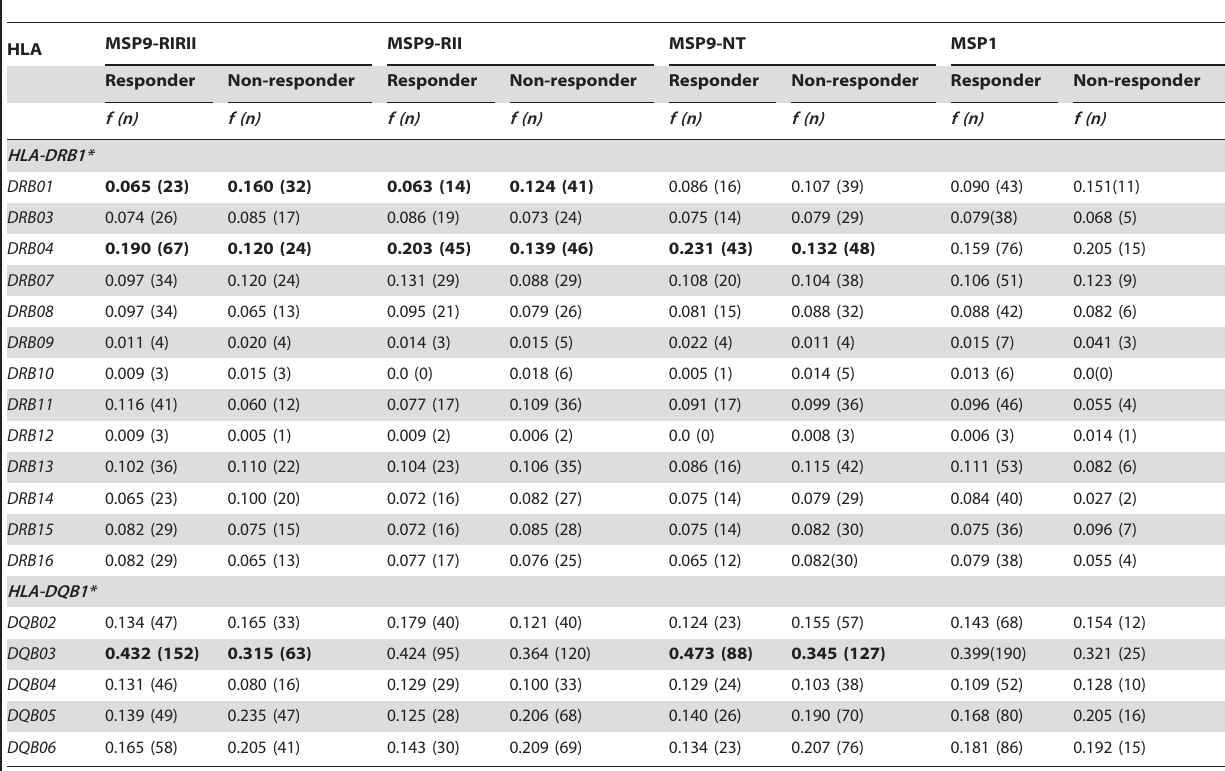
Table 3. Frequency (F) and number (n) of IgG responders and non-responders to the PvMSP-9 and PvMSP-1 recombinant proteins tested by HLA-DRB1* and HLA-DQB1*allelic groups from malaria naturally exposed individuals.